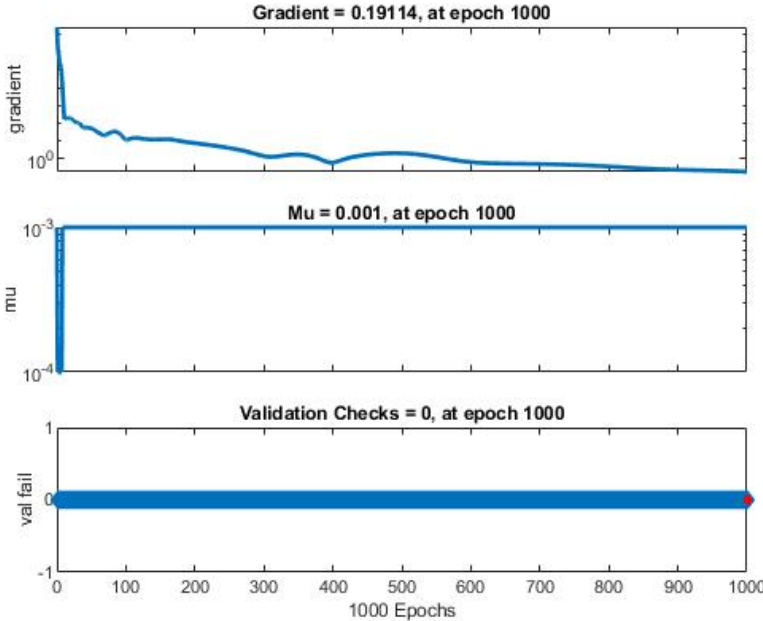
Figure 4. Training state performance.